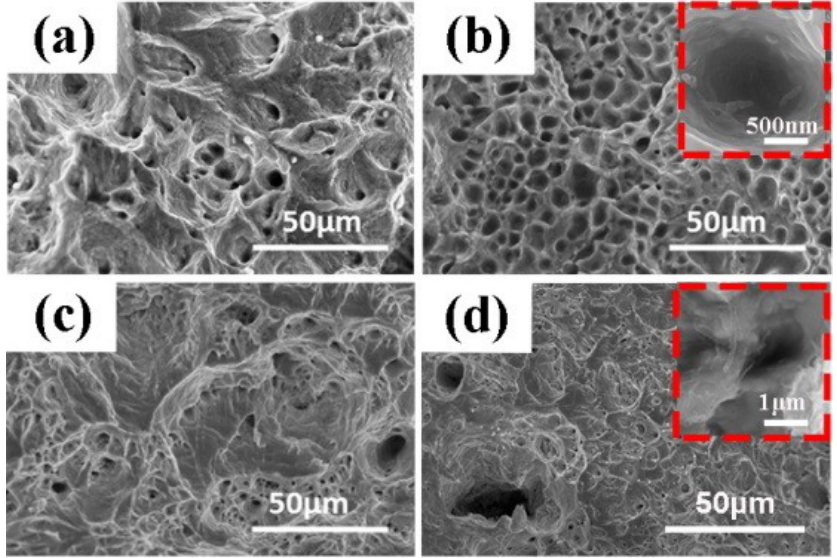
Figure 11. Fracture surface morphologies of the CNTs@Ag/Ag composites with different contents of CNTs by SPS and HP: ( a ) 1 vol.% (SPS), ( b ) 2.5 vol.% (SPS), ( c ) 5 vol.% (SPS), ( d ) 2.5 vol.% (HP).